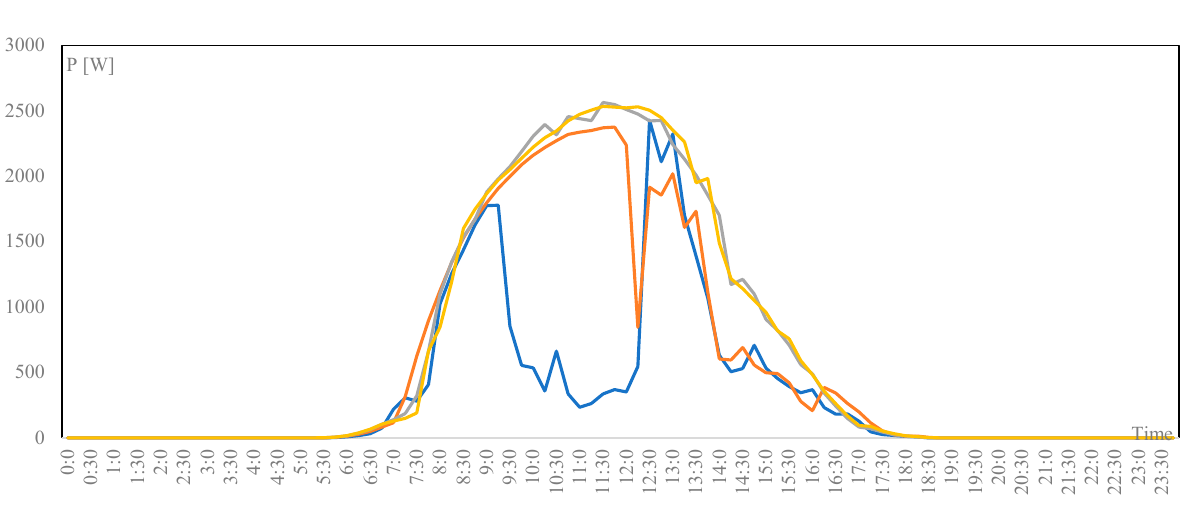
Figure 22. Exchanged power with the storage system for the different AEUs: AEU1 (blue), AEU2 (orange), AEU3 (grey), AEU4 (yellow).